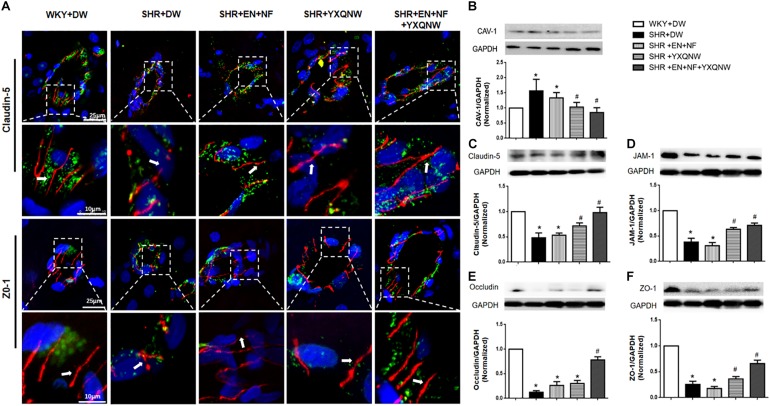
YXQNW protects the decrease in TJ proteins and caveolin-1 expression. (A) Representative immunofluorescence confocal images of claudin-5 and ZO-1. Claudin-5 (red) and ZO-1 (red) localized at the peripheral of endothelial cells with marker vWF (green). Note the continuous distribution of claudin-5 and ZO-1 in cortical microvessels of control group. The disruption of claudin-5 and ZO-1 staining in SHR + DW was not reduced in the SHR + EN + NF group but markedly reduced in the YXQNW treatment group and EN + NF + YXQNW treatment group. White arrows indicate the localization of claudin-5 or ZO-1. (B) Representative Western blots and quantitative analysis of caveolin-1. (C) Representative Western blots and quantitative analysis of claudin-5. (D) Representative Western blots and quantitative analysis of JAM-1. (E) Representative Western blots and quantitative analysis of occludin. (F) Representative Western blots and quantitative analysis of ZO-1. Values are the mean ± SEM. ∗P < 0.05 vs. control group, #P < 0.05 vs. SHR + DW group.